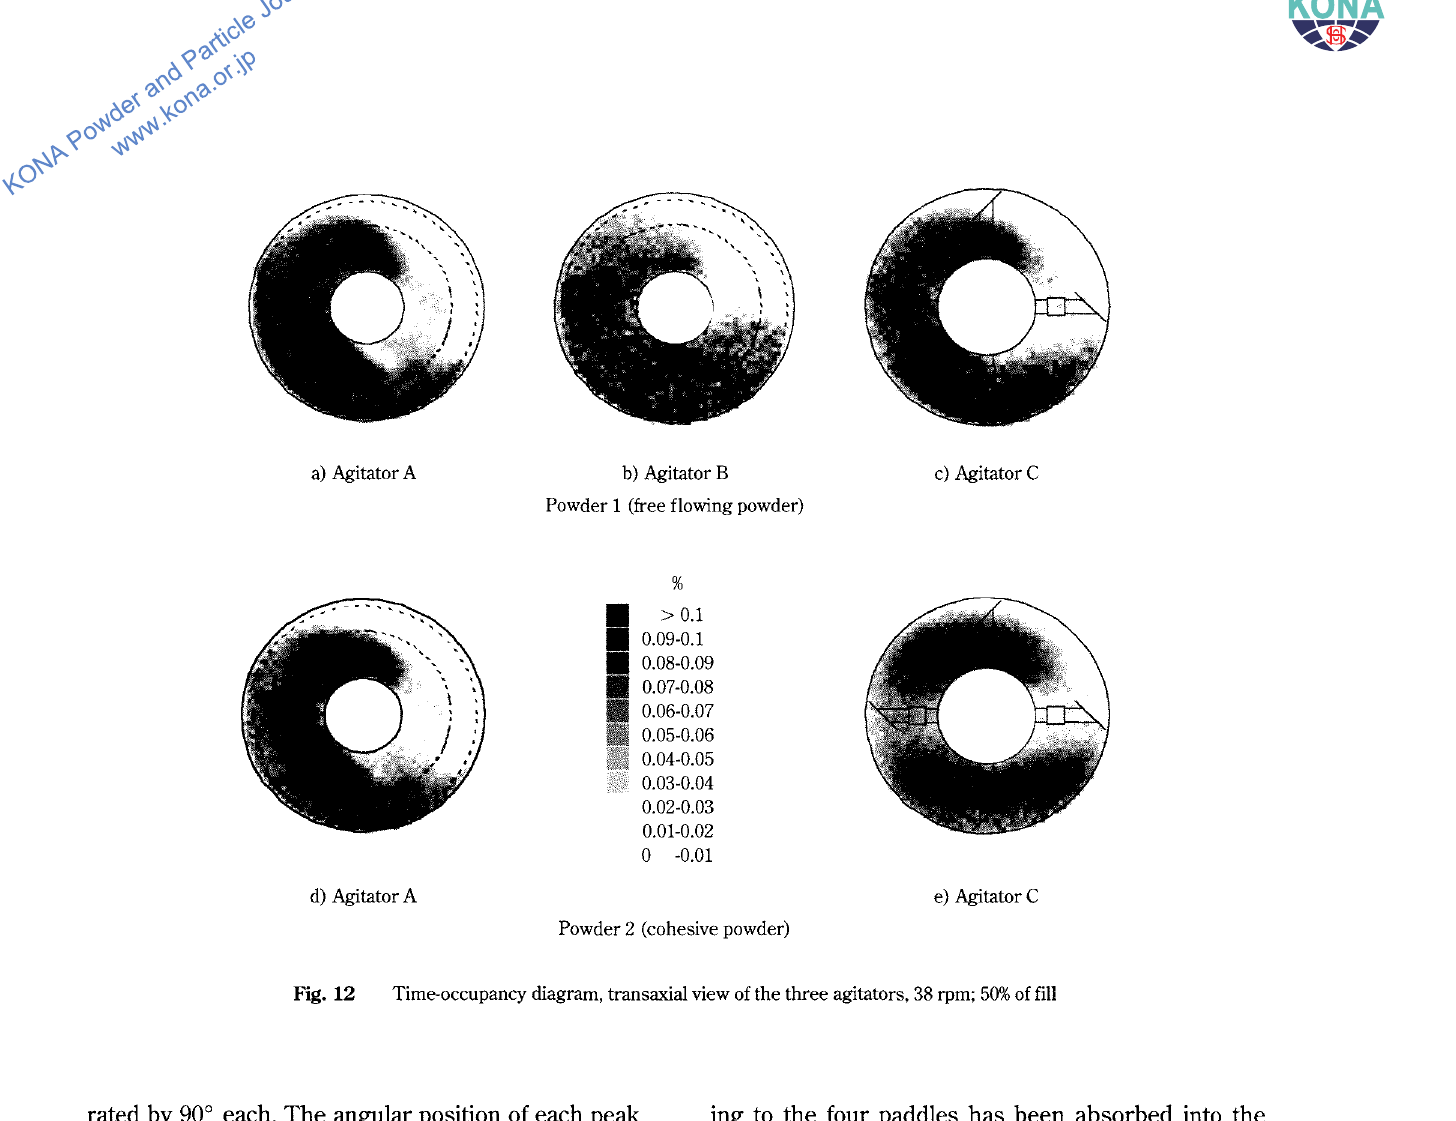
Time-occupancy diagram, transaxial view of the three agitators, 38 rpm; 50% of